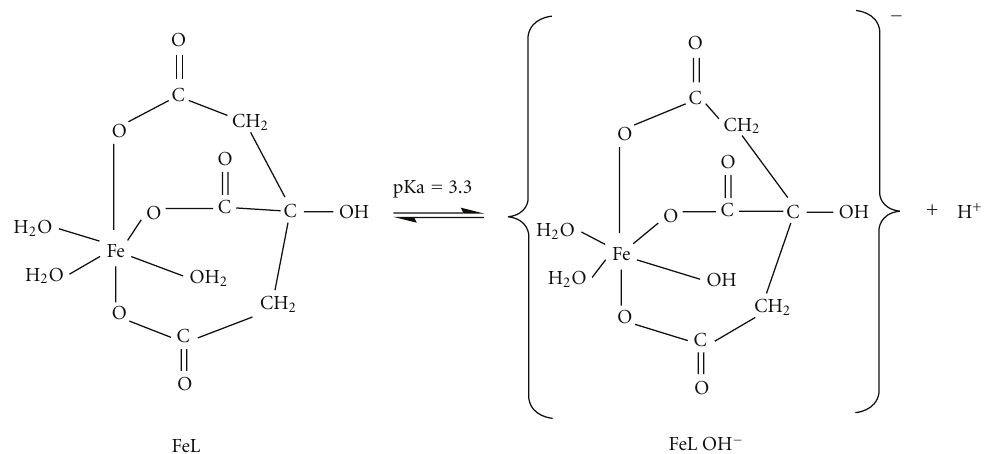
Scheme 1: Structure of Fe(III)-Cit complex.